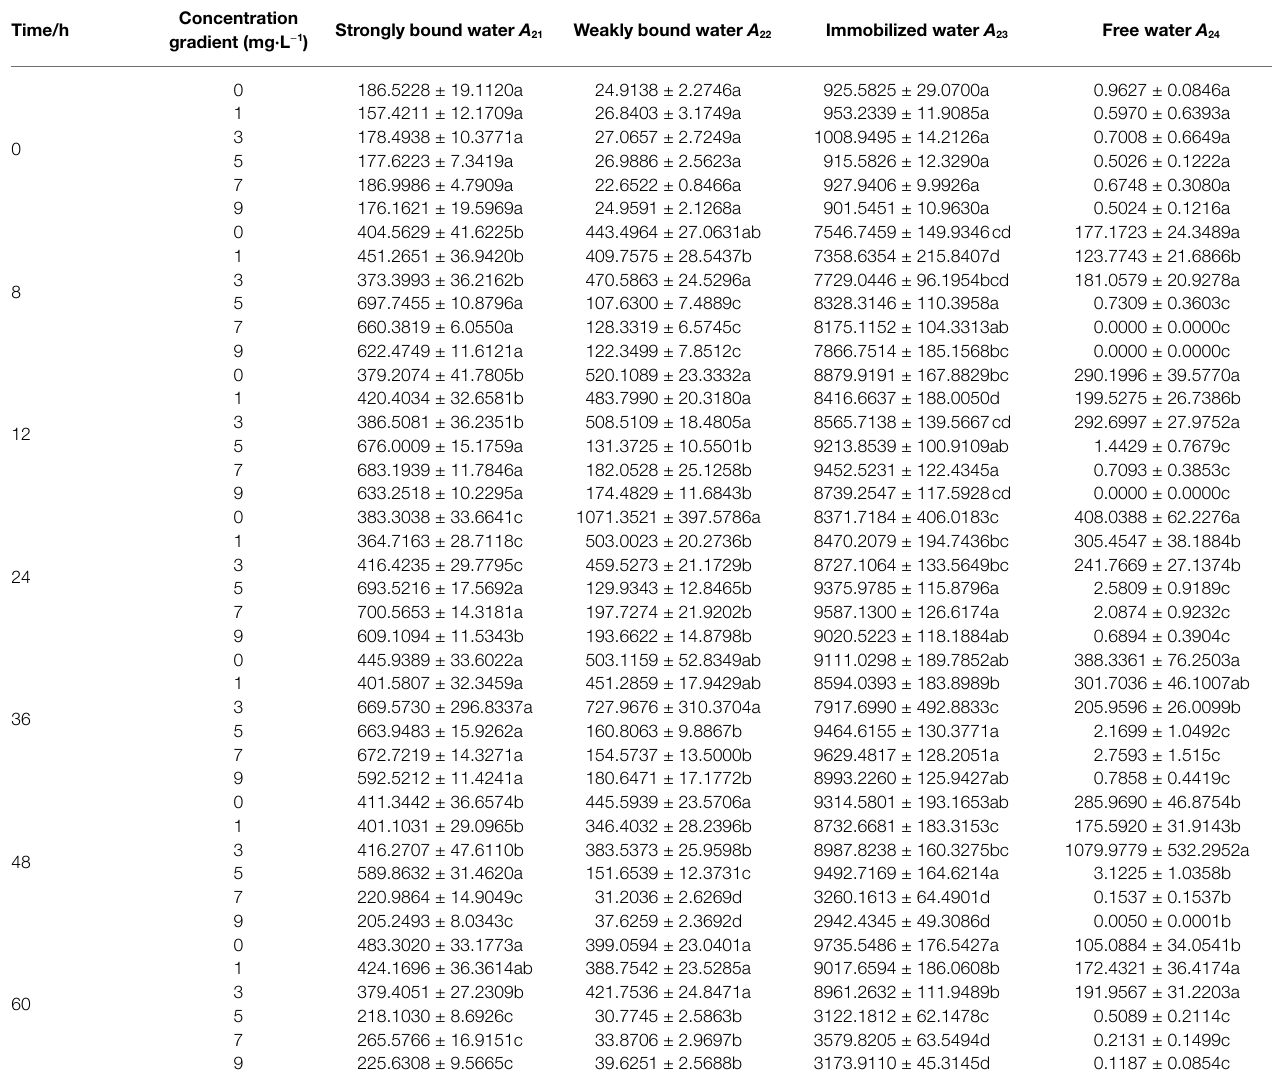
TABLE 1 | Statistics table of unit mass T 2 peak area.